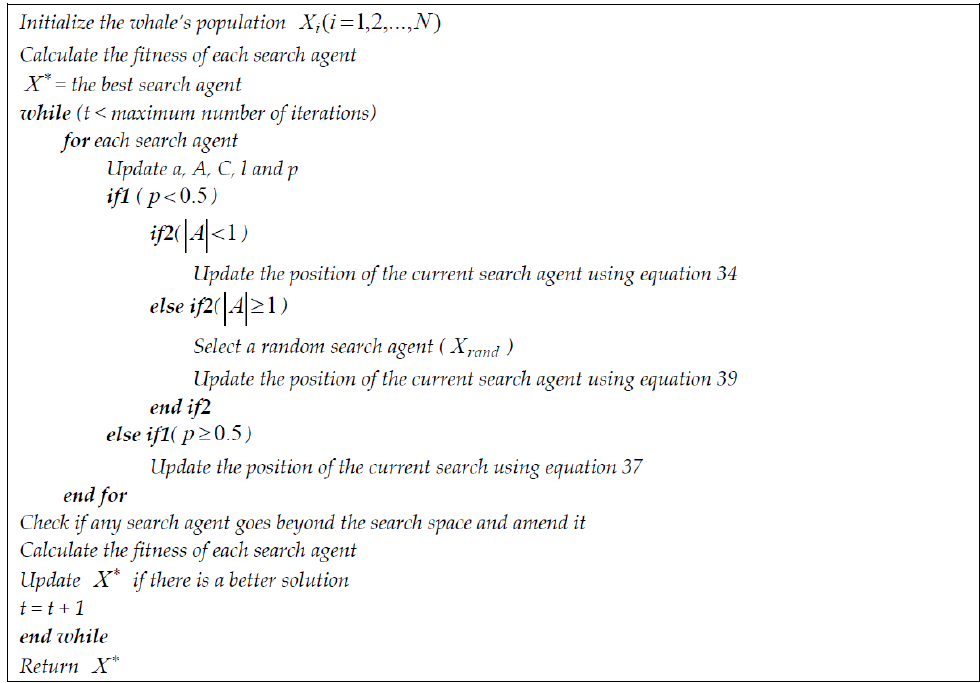
Figure 4. Pseudo code of the Whale Optimization Algorithm algorithm.